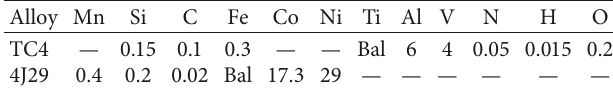
Table 1: Chemical composition of base metals